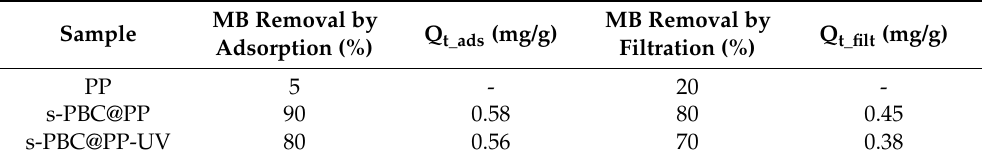
Table 2. MB removal (%) and amount of adsorbed dye per gram of adsorbent (Q t , mg/g), considering the peak at 664 nm after adsorption and filtration